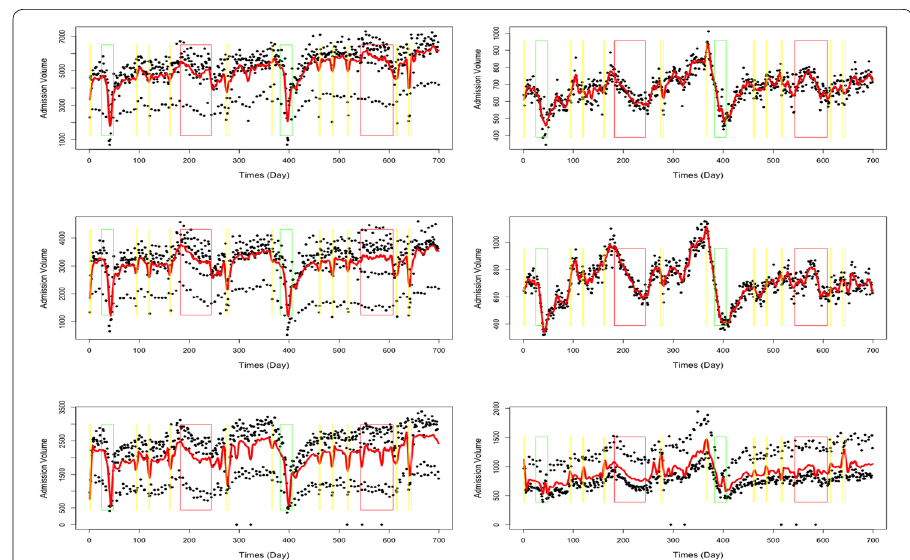
Fig. 1 Time plot of daily admissions from January 1, 2013 to November 30, 2014. Left diagram is outpatient admissions, and the right is emergency admissions; the upper diagram is Hospital A, middle is Hospital C, and lower diagram is Hospital D. Red lines indicate the de‑seasonalized trend in hospital admissions. Green and red boxes represent winter and summer school vacations, and yellow boxes are public